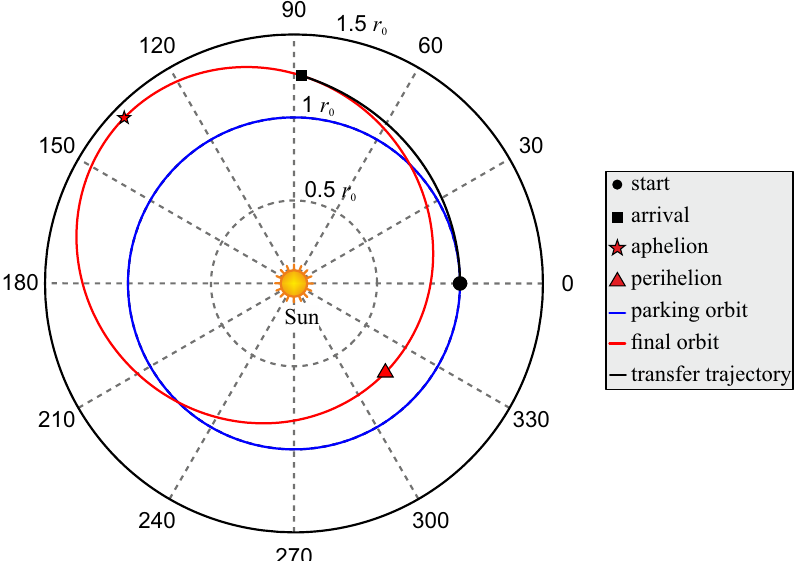
Figure 5. Optimal transfer trajectory when e f = 0.3 and β =